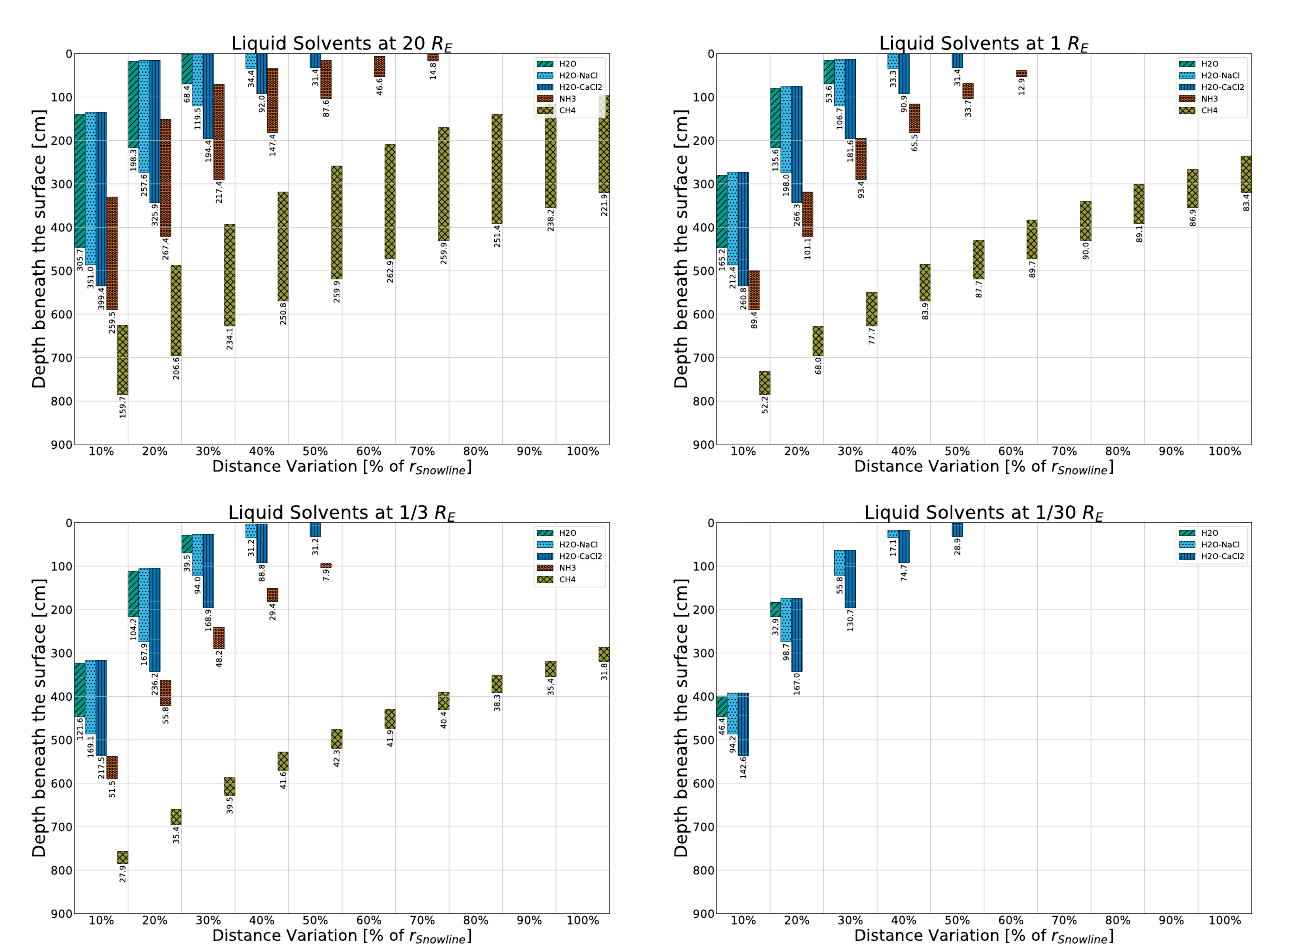
Figure 4. Liquid solvent layers within 10 m of the surface of four model bodies of rocky, freshwater surface composition around a modeled X-ray source. From top left to bottom right, the four bodies R earth , respectively. The surface density of the rocky, freshwater model are of the sizes 20,1, 1 , and 1 3 30 involved is ρ surface = 2.2765 g , with the composition shown in Table 1. Numbers labeling the cm 3 columns show the thickness of the liquid layers in